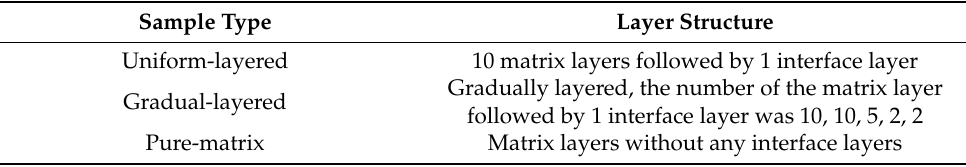
Table 1. The layer structure for different sample types.